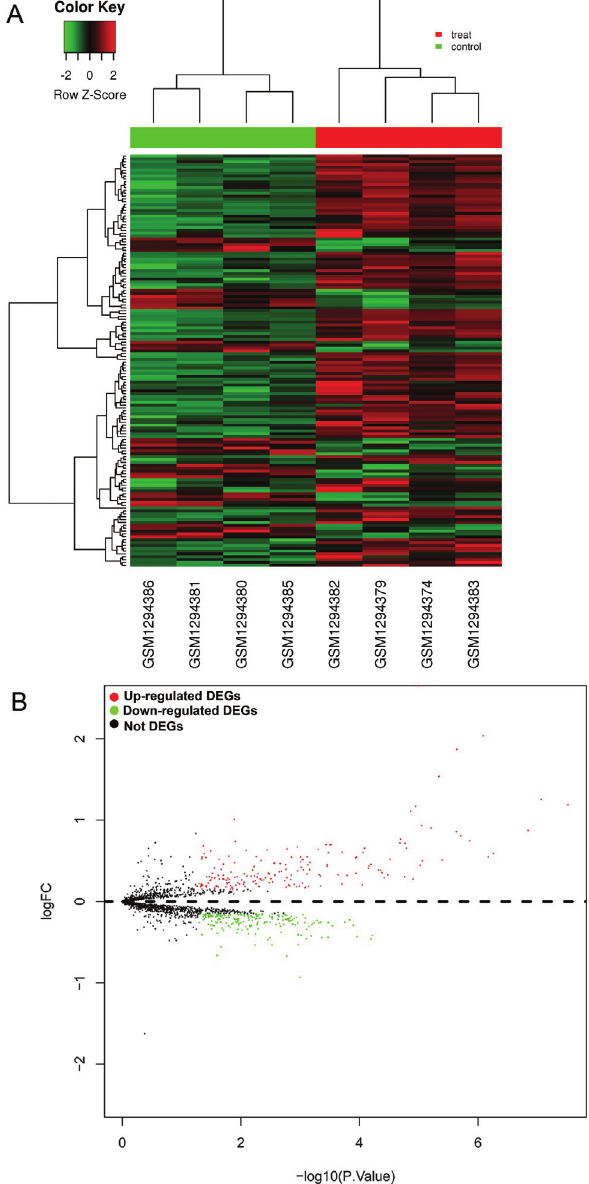
Figure 1 - The DEGs in AD mice compared with wild-type mice. A: Heat map analysis. B: Volcano plot analysis. Green represents down-regu- lated.DEGs, red represents up-regulated DEGs.